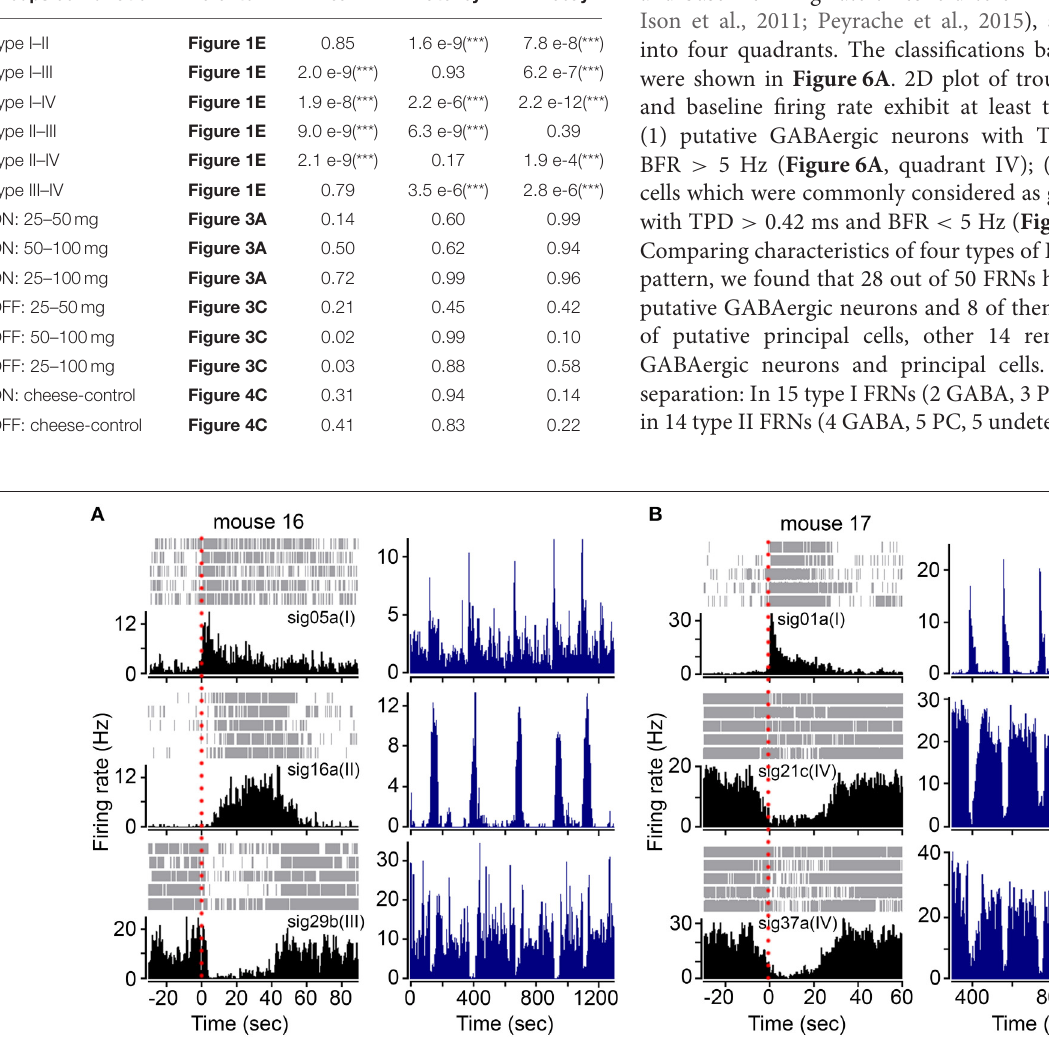
FIGURE 2 | FRNs orchestrate during food intake in type specific pattern. (A) Three simultaneously recorded different types of FRNs (type I, II, and III) during feeding behavior in one mouse. (B) Three simultaneously recorded different types of FRNs (type I, IV, and IV) during feeding behavior in another mouse. Onset of feeding was aligned by red dashes in PETH (left panel). Type I and III FRNs peaked exactly at the beginning of food intake, while type II and IV respond slowly and peaked in the middle of food intake.